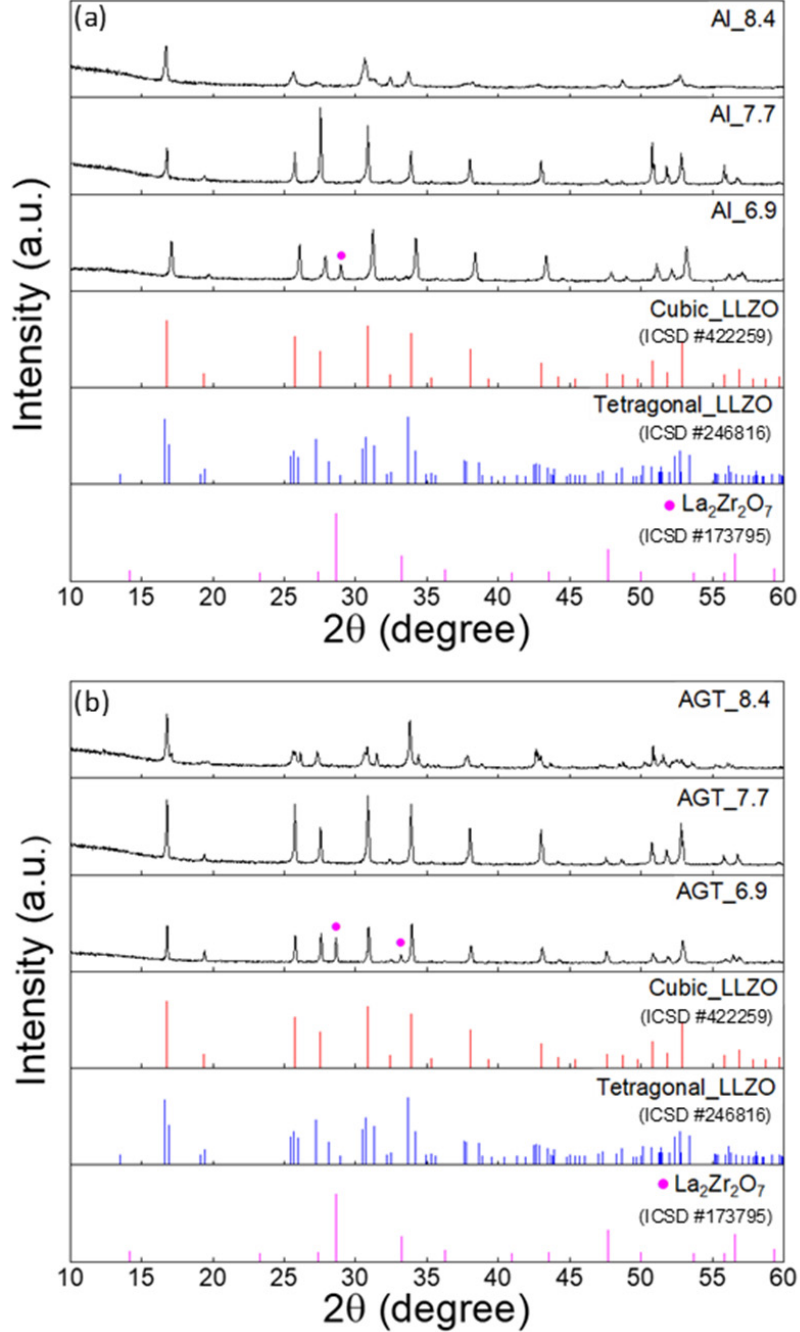
Figure 2. XRD patterns of ( a ) Al-doped LLZO pellets and ( b ) Al/Ga/Ta-doped LLZO pellets with different Li + concentrations (6.6, 7.7, and 8.4 mol). The peaks marked by purple dots are attributed to La 2 Zr 2 O 7 . The red, blue and purple vertical lines represent the standard diffraction peaks of cubic LLZO, tetragonal LLZO and La 2 Zr 2 O 7 , respectively.